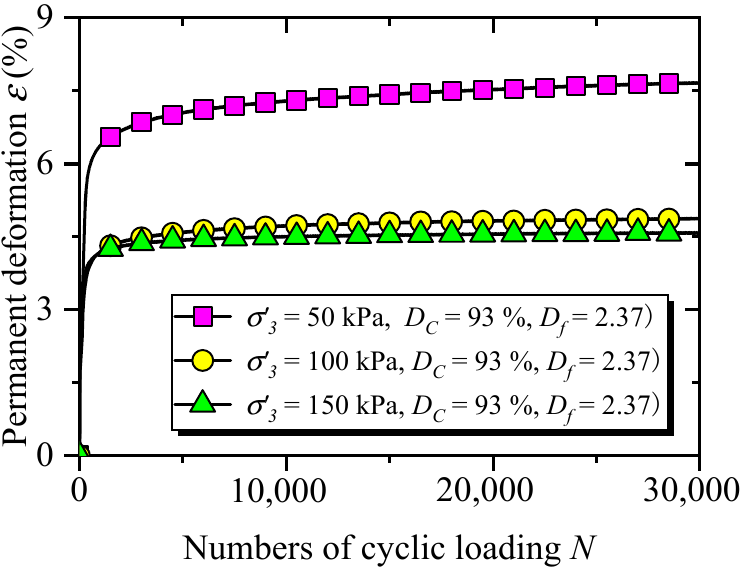
Figure 8. The relationship between ε and N with different confining pressure